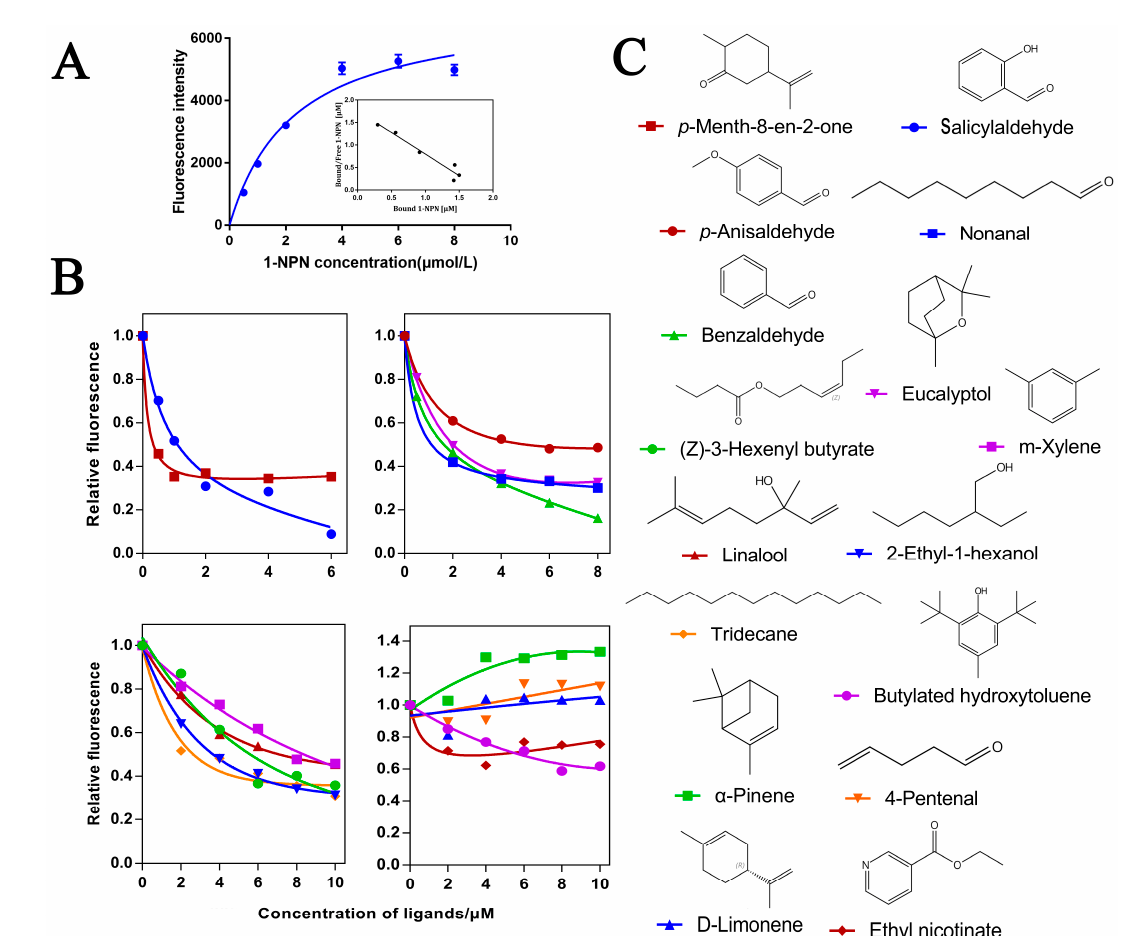
Figure 3 . Affinity of recombinant O.lotOBP6 to candidate chemical ligands. ( A ) Binding curves and Scatchard plots of 1-NPN to O.lotOBP6. ( B ) Competition binding curves of O.lotOBP6 and ligands. ( C ) The chemical structures of the chemical ligands.